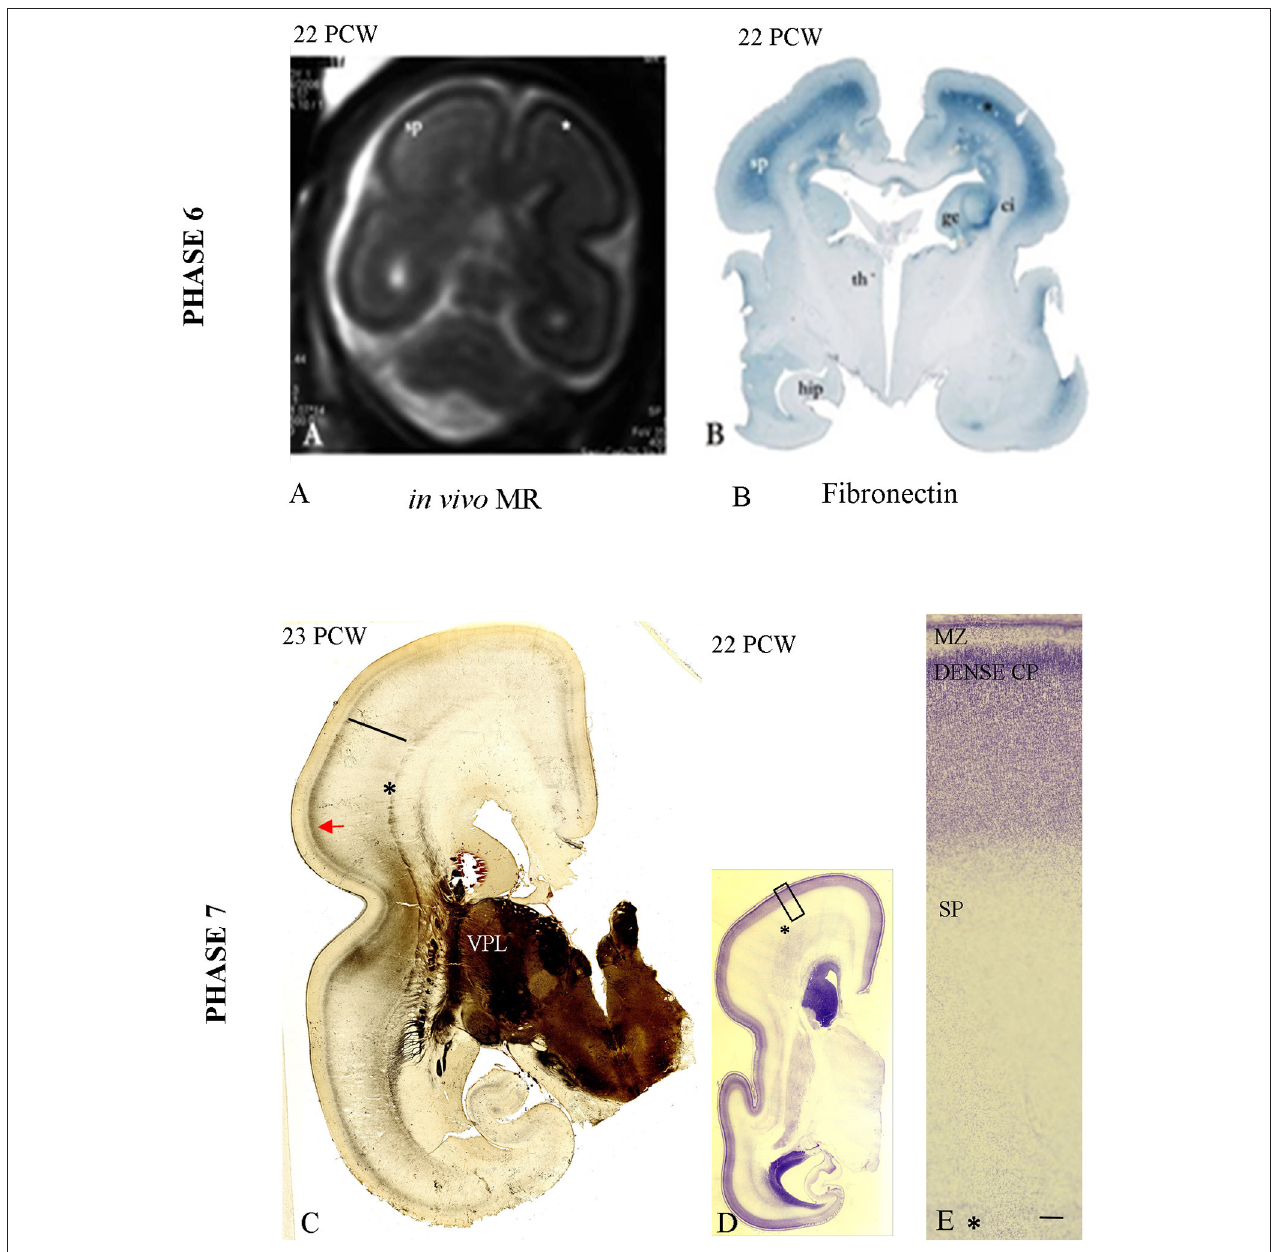
FIGURE 6 | In vivo image of the fetal telencephalon at 22 PCW (A); accumulation of TH-C fibers in superficial SP marked with (*) corresponding to the fibronectin-immunoreactive SP [ B , already presented by Kostovic et al. (2006)]. (C) Shows the first AChE reactive band in the prospective somatosensory CP while the remaining AChE reactive fibers are still in the superficial SP (arrow). ( D,E : The initial lamination of the CP on Nissl preparation (low and high magnification). Asterisk marks border between SP and fiber strata of the intermediate zone (fetal white matter); bar marks SP. Scale bar: 100 µ m.